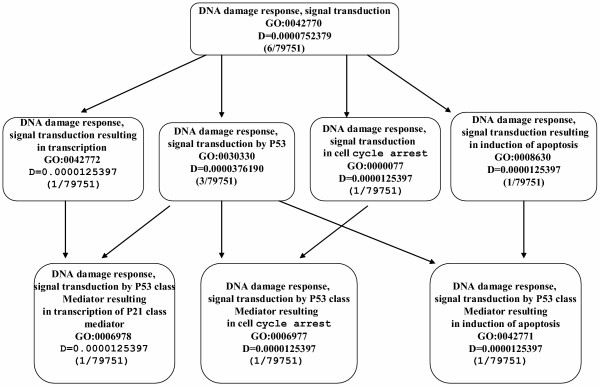
Subgraph of the GO Biological Process directed acyclic graph (data source: DAG-Edit Version 1.419 Rev 3). Each box represents a GO term with term definition, GO ID, and D-value D; there are two forms for D-value, decimal and fractional; the nominator in the fraction is the count of the GO term, the denominator is the count of the whole GO DAG root.